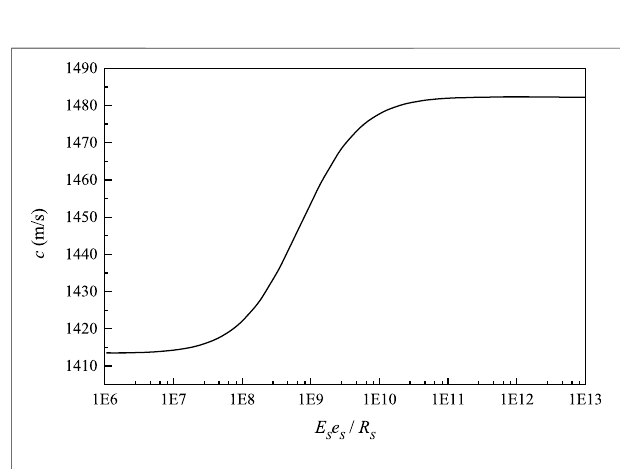
FIGURE 10 | Pressure wave speed varies with E s e s /R s